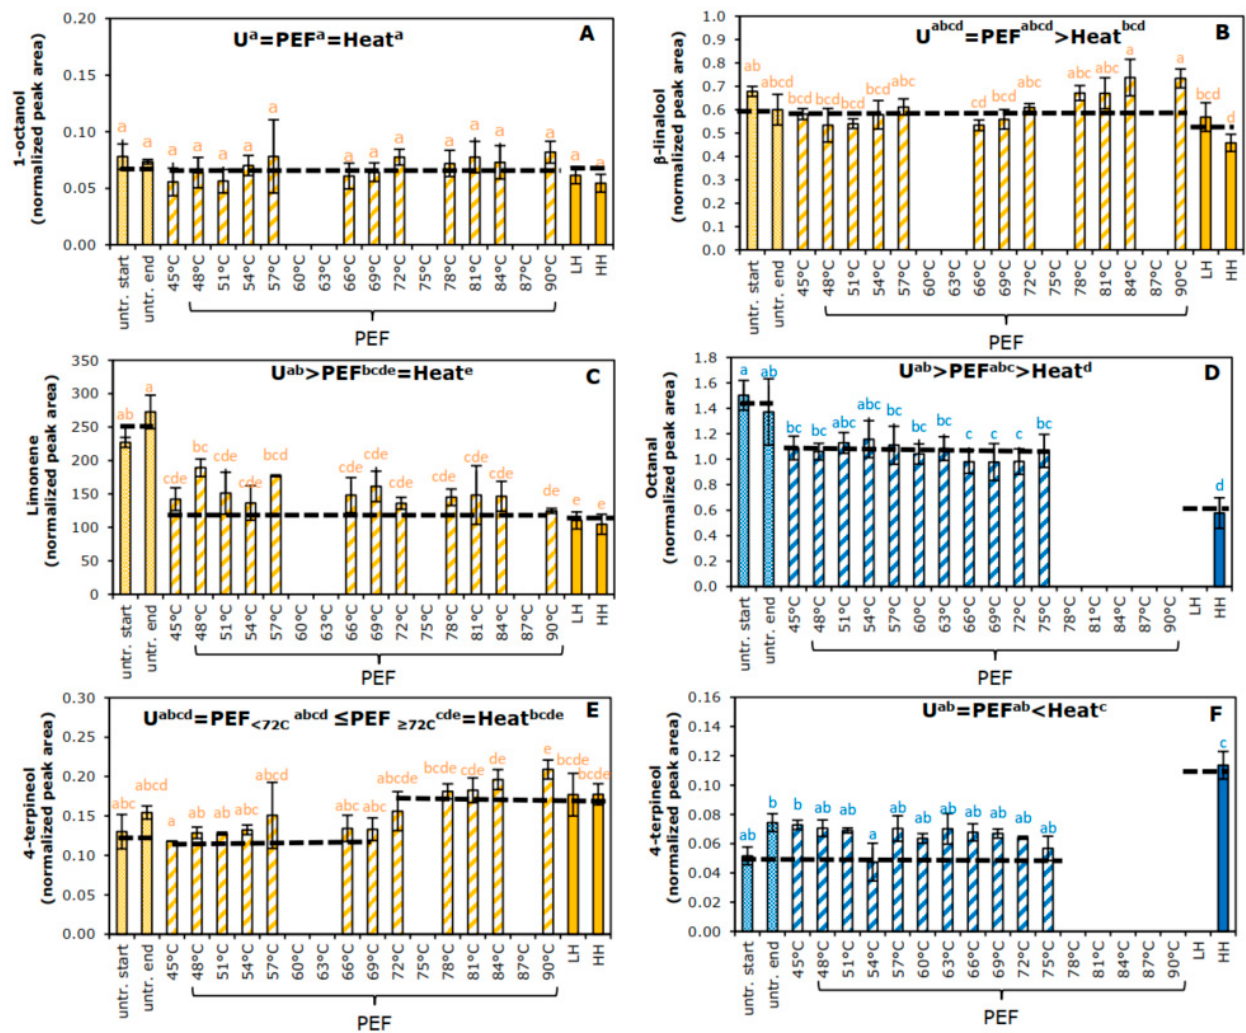
Figure 6. Trends illustrating the effect of processing on the detected volatiles present in orange juice, discriminating untreated juice (U), moderate intensity PEF-treated juice (PEF), and thermal-treated juice (heat). Six trends were identified, one trend showed no processing effect: U = PEF = heat (shown in ( A ) for 1-octanol), three trends showed a decrease of the compound after PEF and/or thermal processing compared to untreated, being U = PEF > heat (shown in ( B ) for β -linalool), U > PEF = heat (shown in ( C ) for limonene), and U > PEF > heat (shown in ( D) for octanal); and two trends showing an increase of the compound after PEF and/or thermal processing compared to untreated: U = PEF low < PEF high = heat (shown in ( E ) for 4-terpineol) and U = PEF < heat (shown in ( F ) for 4-terpineol). Bars represent the average of three measurements with standard deviation. Trends for each specific compound are shown in the Appendix A, and summarized in Table 2. Statistical differences between the treatments are indicated with a letter per juice, with matching letters showing no significant difference.